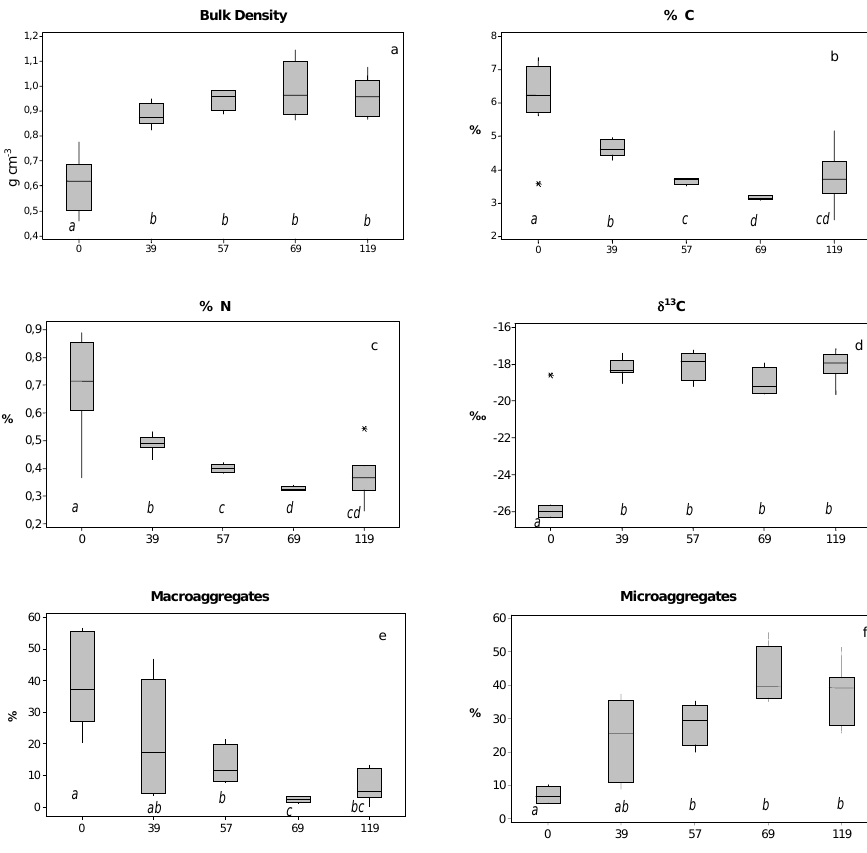
Figure 3. Boxplots of soil parameters. a) Bulk density, b) soil carbon (%C), c) soil N (%N), d) δ 13 C, e) Macroaggregates, f) Microaggregates. x-axis scale is time since conversion. * represents outliers. Box plot shows median, i.e. line in grey box, the first (below median line) and third (above median line) quartiles. Whiskers extends to the maximum or minimum data point within 1.5 box heights from the top or bottom of the box. Letters in italics below bars represents significance. Years since conversion not followed by the same letter are significantly different (p<0.05, Mood Median test).